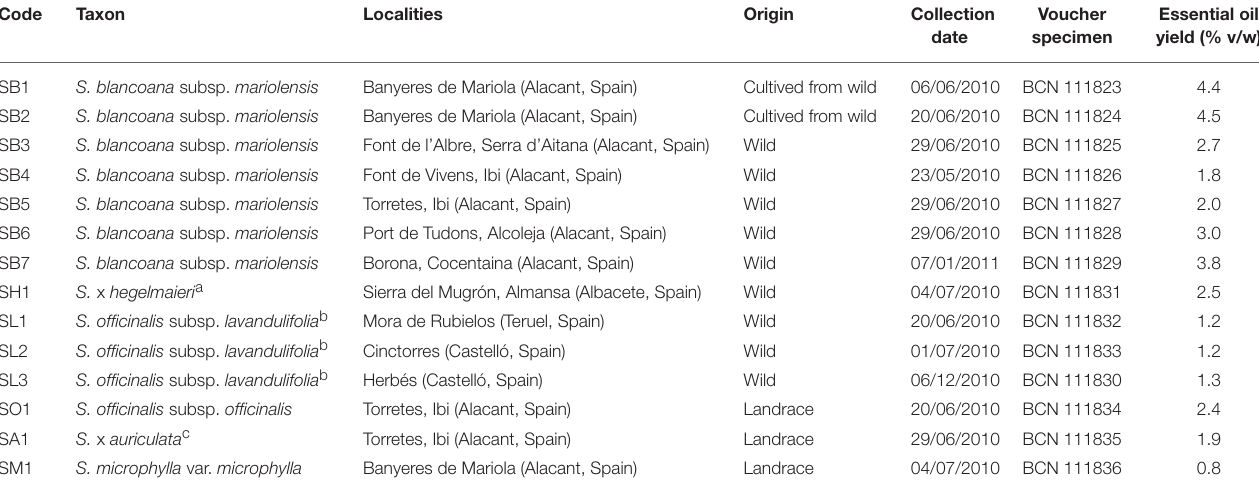
TABLE 1 | Collection data and essential oil yield for the aerial pats of the Salvia taxa